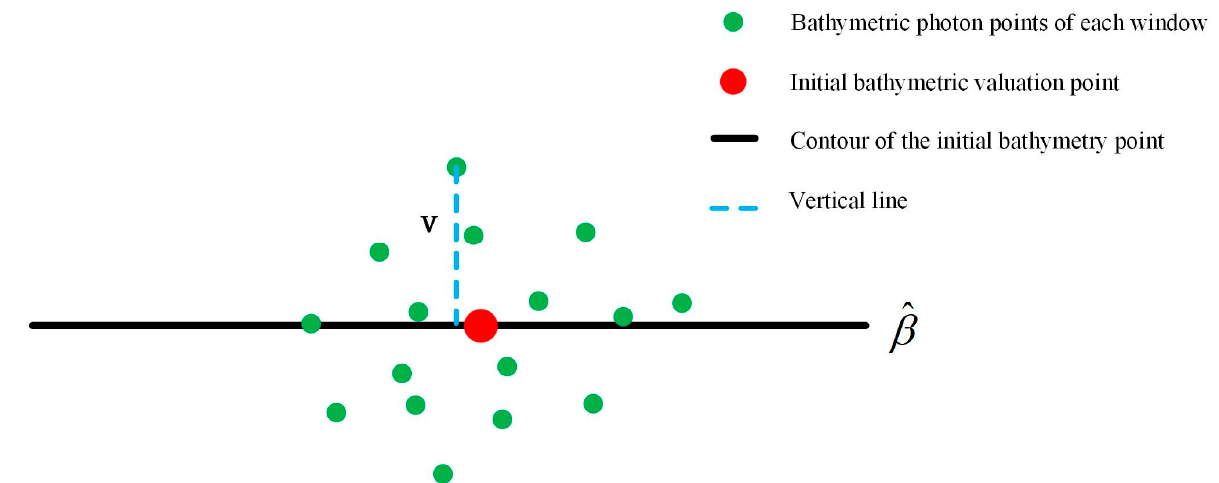
Figure 4. Schematic of robust M-estimation of water depth.